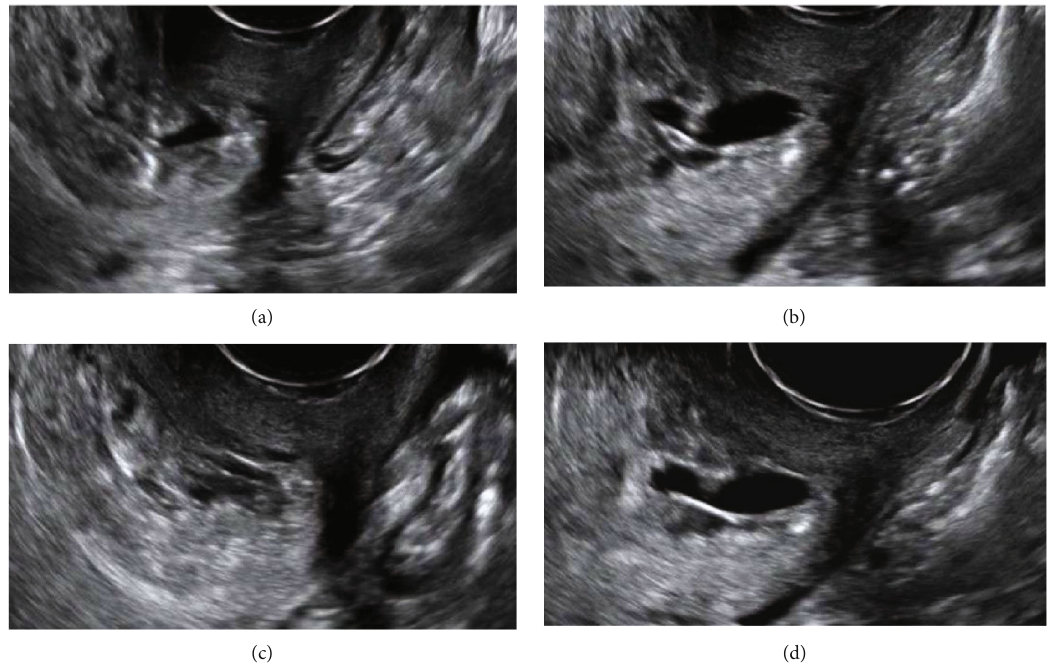
Figure 2: Transabdominal puncture using a 17-gauge needle under transvaginal ultrasound guidance. Aspiration of (a, b) gestational content followed by (c, d) local methotrexate